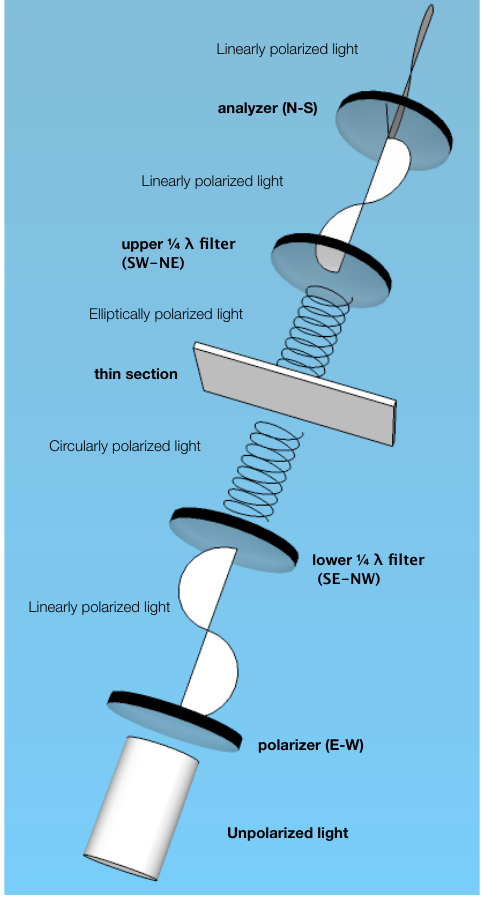
Figure 2. Optical filter configuration of a typical circular polarization microscope for transmitted light illumination. The operator to specimen direction is considered South-North (S-N). Other directions in the figure are E-W: East-West, SE-NW: Southeast-Northwest, SW-NE: Southwest-Northeast, N-S: